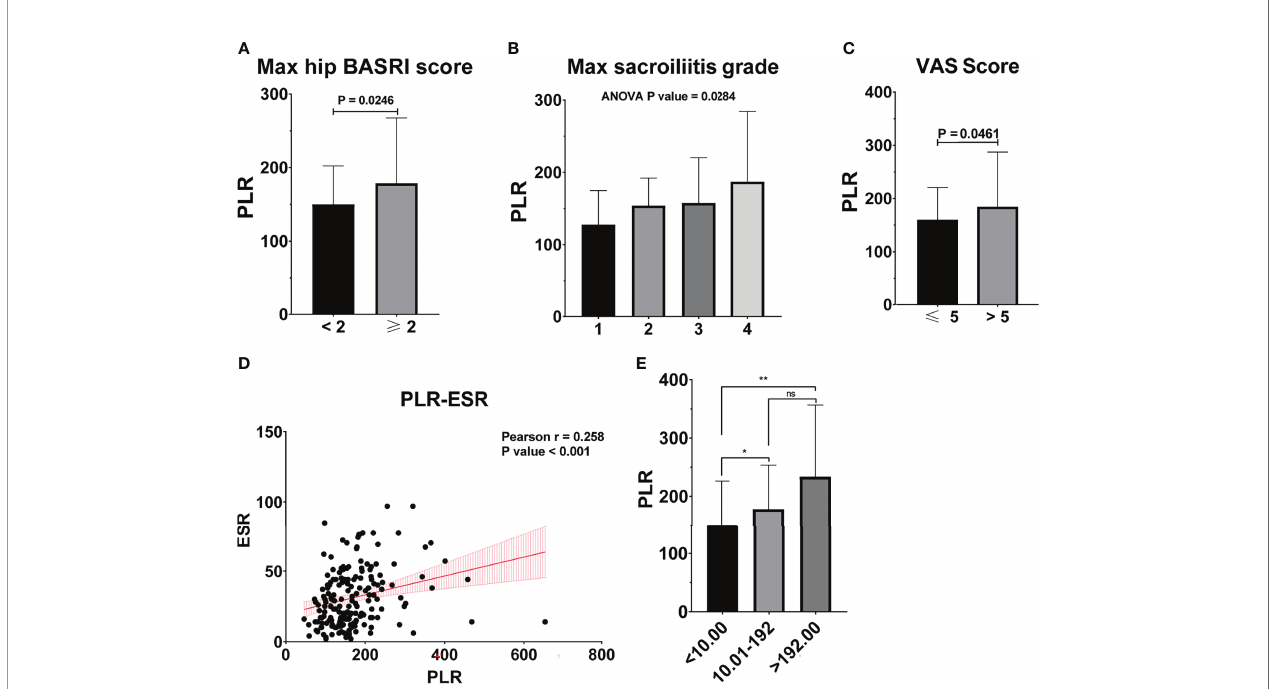
FIGURE 4 | PLR is associated with the severity of AS. (A) PLR between AS patients with max hip BASRI socre < 2 and ≥ 2. (B) PLR in AS patients with different max sacroiliitis grade. (C) PLR between AS patients with different VAS pain score. (D) The correlation of PLR with ESR. (E) PLR between AS patients with different CRP group. * representative p value < 0.05; ** representative p value < 0.01. ns representative p value > 0.05.